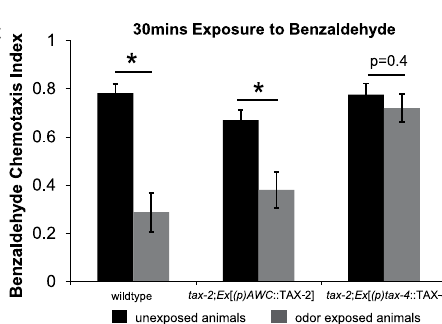
animals expressing CNG-3[S20A] (Fig. 3D: line 1, 2 nd set of bars and line 2, 3 rd set of bars). In each line of CNG- 3[S20A] we observed a small though significant change in the chemotaxis index of animals that were exposed to benzaldehyde for 30 mins as compared with the unexposed control animals (Fig. 3D, 2 nd and 3 rd set of bars: p < 0.05). Interestingly, the chemotaxis response after odor exposure when compared to unexposed animals for the transgenic lines expressing CNG-3[S20D] or CNG-3[S20A] was smaller and less significant (Fig. 3C,D, 2 nd and 3 rd set of bars: * p < 0.05) when compared to the adaptation responses of wildtype animals (Fig. 3C,D, 1 st set of bars: ** p < 0.01). Thus, in each case, the extent of adaptation is less than that of the wild type. This indicates that expressing a CNG-3 subunit that either cannot be phosphorylated or mimics phosphorylation at serine 20 creates a dominant negative channel that interferes with adaptation. Next, we examined the chemotaxis responses of transgenic animals expressing CNG-3[S20D] or CNG- 3[S20A] to various concentrations of the AWC sensed odors butanone (Fig. 3E) and benzaldehyde (Fig. 3F). In the case of animals expressing CNG-3[S20A] (line 2), we observed similar responses to that of wildtype ani- mals and also to control animals expressing a wildtype copy of CNG-3 (CNG-3[WT]) for various concentrations of butanone (Fig. 3E: p > 0.05 for each dilution) and also for various concentrations of benzaldehyde (Fig. 3F: p > 0.05 for each dilution). Interestingly, in the case of animals expressing CNG-3[S20D] (line 1) we observed a heightened sensitivity to more dilute concentrations of odor for butanone at concentrations of 1 part per 100,000 (Fig. 3E: p < 0.05 for CNG-3[S20D] versus all other strains tested). Also, in the case of benzaldehyde at concen- trations of 1 part per 1000 and also for 1 in 10,000 dilutions we observed significantly higher chemotaxis indices